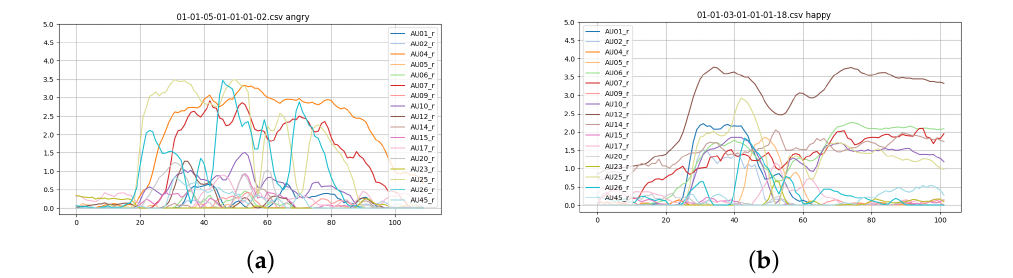
Figure 3. Plots of the 18 AUs generated by the OpenFace library [71] for the intensity version ranging from 0 to 5 of two videos of the RAVDESS dataset. ( a ) AUs’ intensities for an angry sample; ( b ) AUs’ intensities for a happy